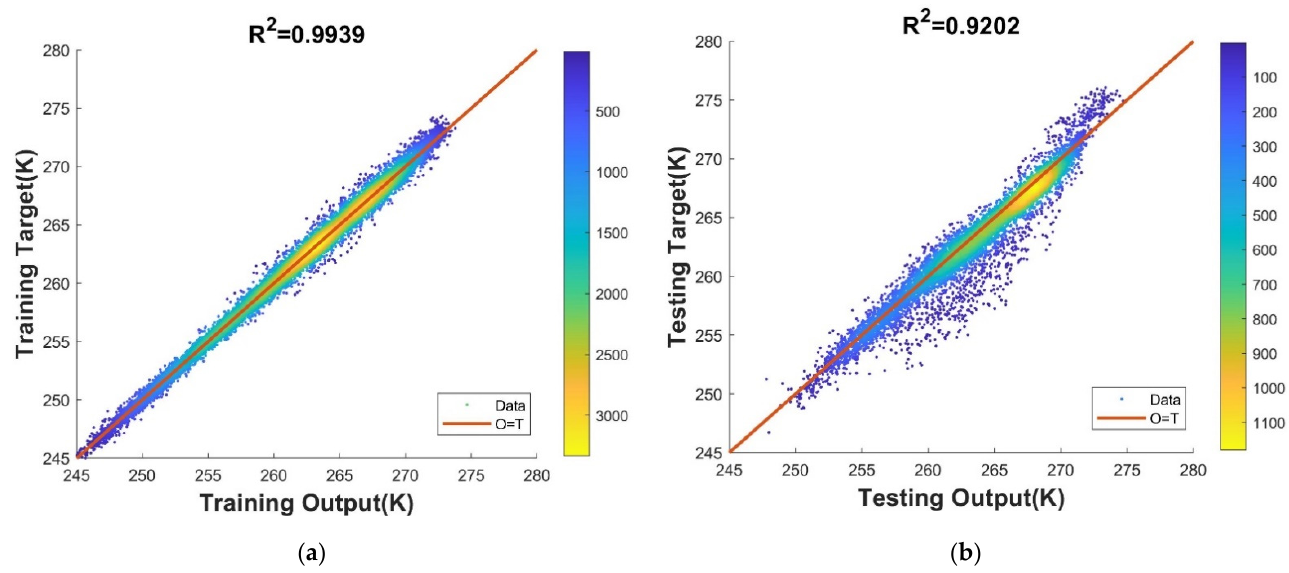
Figure 6. ( a ) Training set and ( b ) test set verifying the fitting effect of the CNN models. The color bar shows that different colors represent different densities, and the value in the color bar is the number of data points within 1K of the current position.